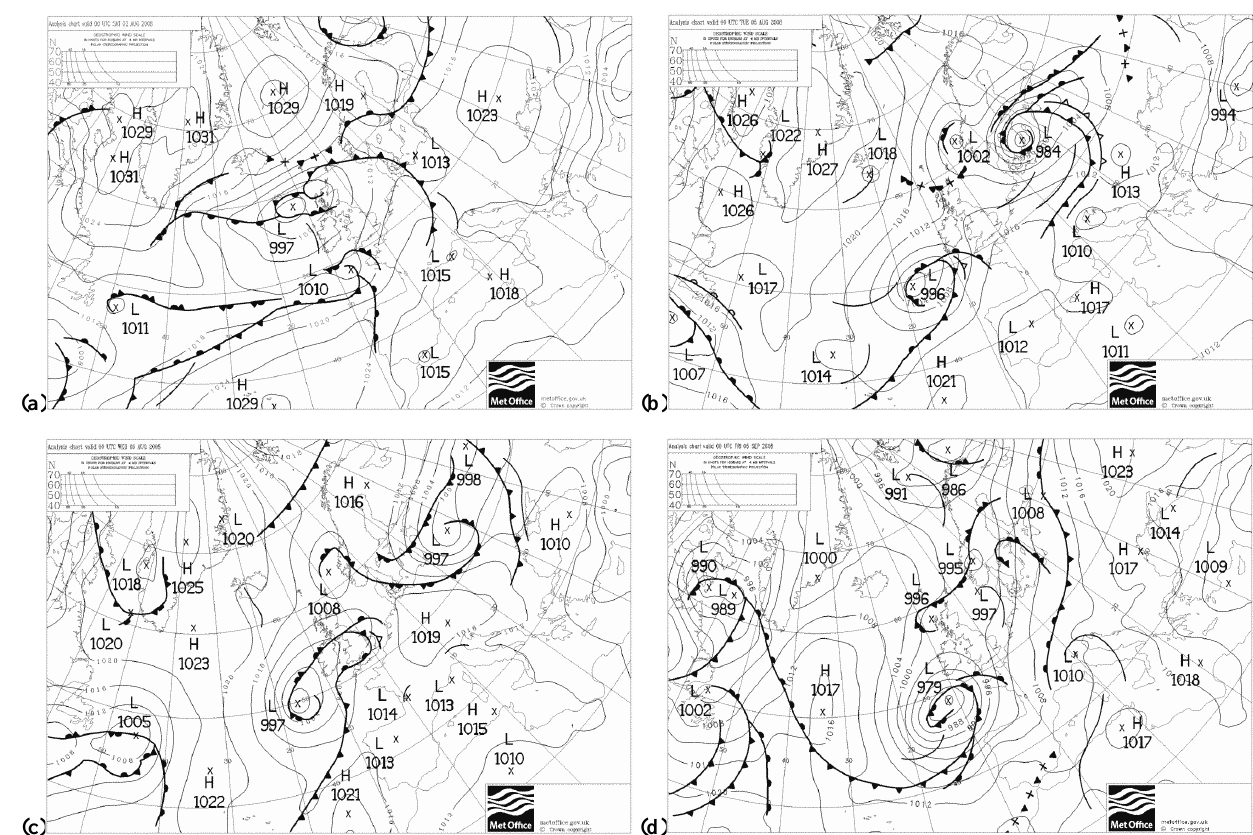
Figure 9. Analysis charts from UK Met O ffi ce Archive (2008) at 00:00UTC on 2 August 2008 (a) ; 5 August 2008 (b) ; 6 August 2008 (c) and 5 September 2008 (d)